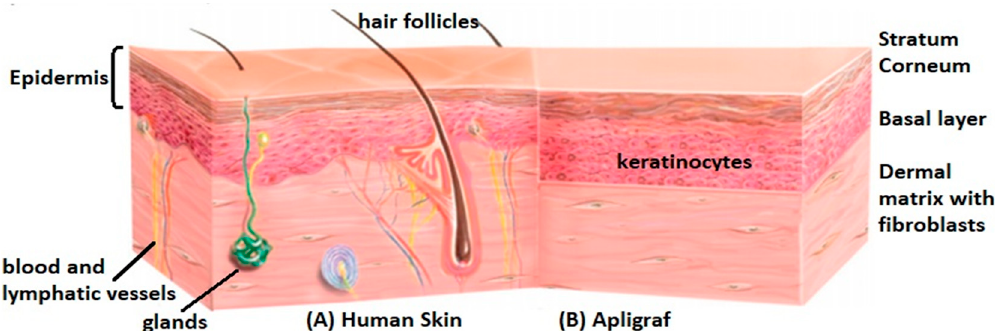
Figure 1. Anatomic differences between native skin ( A ) and an example of dermo-epidermal equivalents, namely Apligraf [11] ( B ). A typical dermo-epidermal equivalent includes a dermal matrix with embedded fibroblasts and the different sublayers of the epidermis, but it lacks hair follicles, sebaceous and sweat glands, blood and lymphatic vessels of the native human